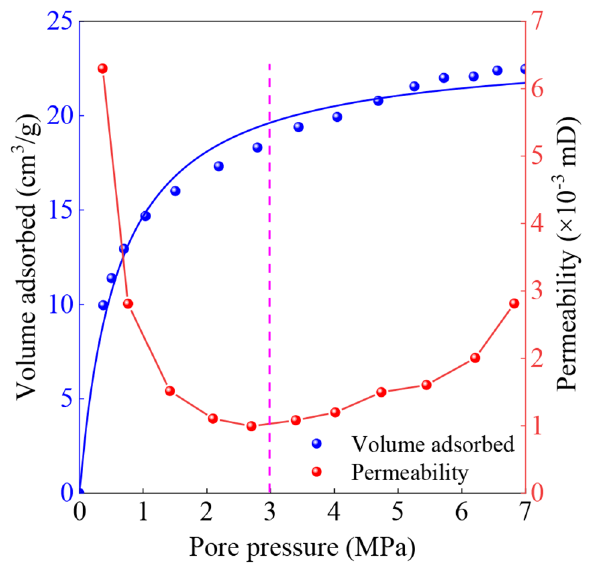
Fig. 11 Adsorption volume of CH 4 and permeability versus pore pres- sure (Harpalani and Schraufnagel 1990)